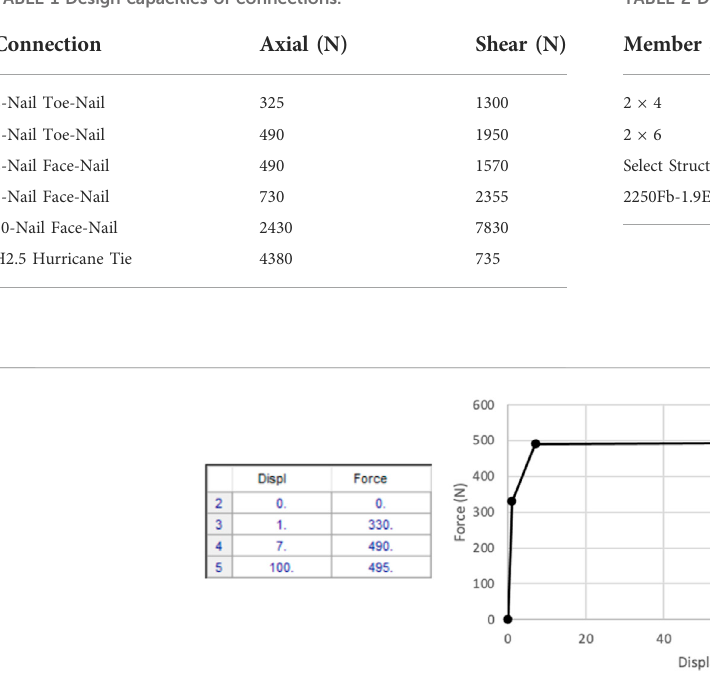
TABLE 2 Design capacities of